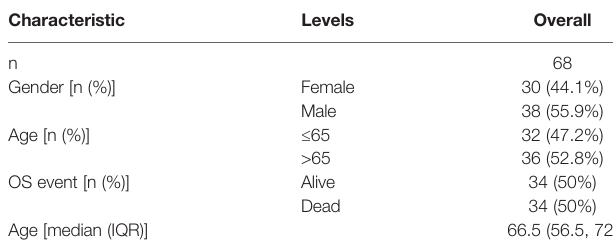
TABLE 2 | Clinical characteristics of the GBM patients used in the validation